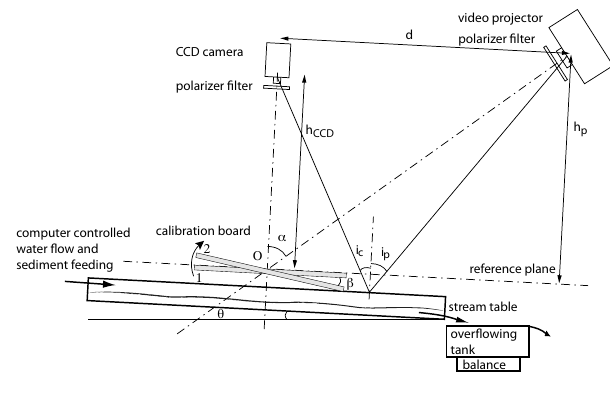
Fig. 1. Experimental setup.